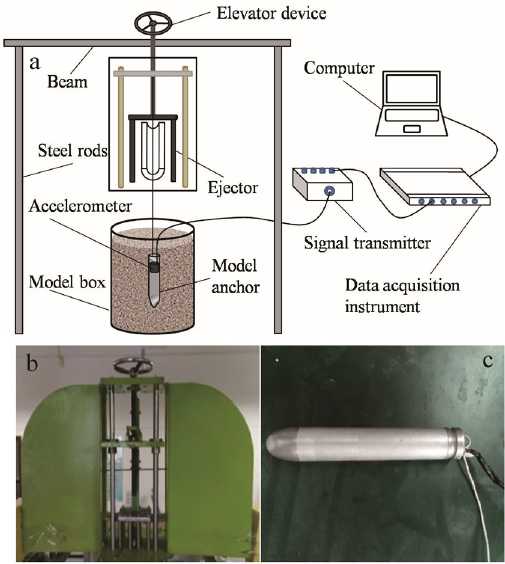
Figure 4. Schematic of the model test setup ( a ) layout of penetration test; ( b ) ejection device; ( c ) torpedo anchor.